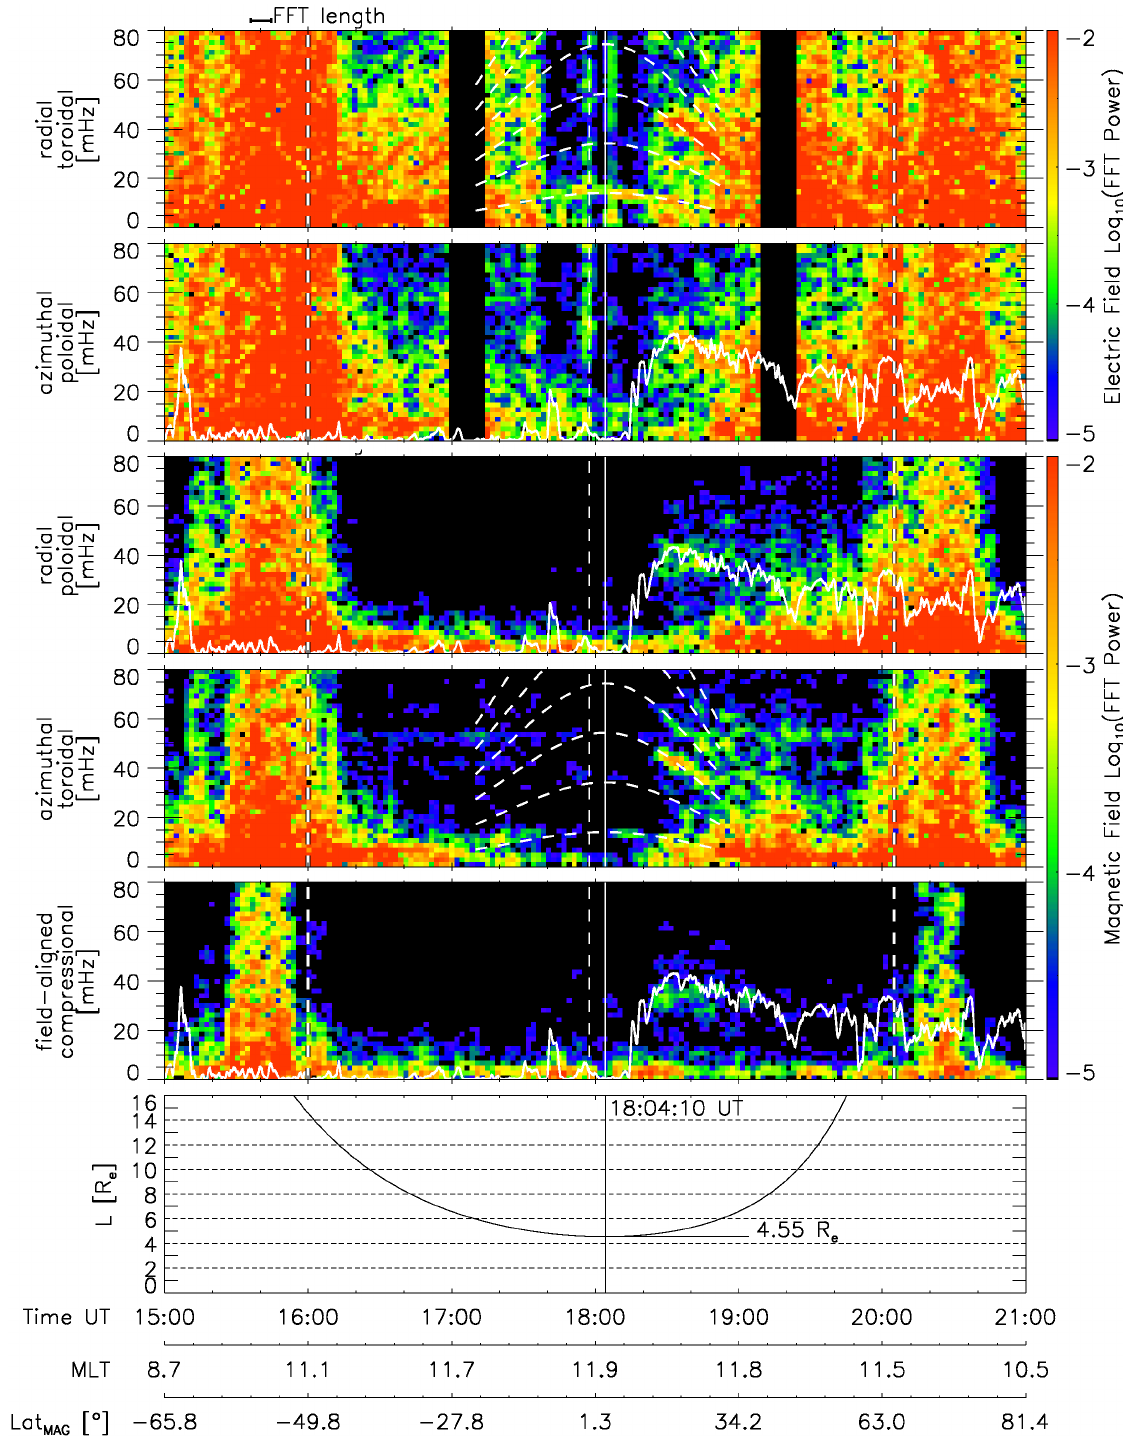
Fig. 5. Same format as Fig. 4, but s/c 2 data on 05 September 2002.